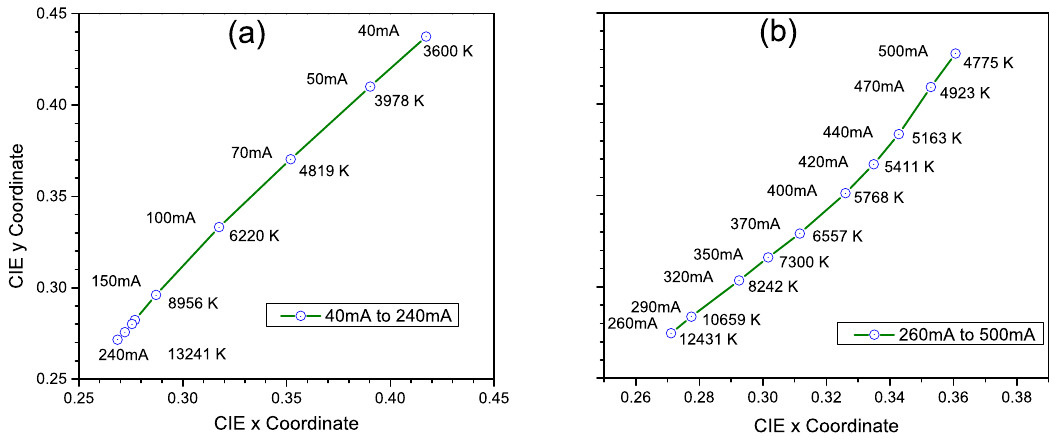
Figure 4. Commission International de I’Elairage (CIE) Chromaticity coordinates and corresponding CCT at various injection currents: ( a ) current from 40 mA to 240 mA; and ( b ) current from 260 mA to 500 mA.